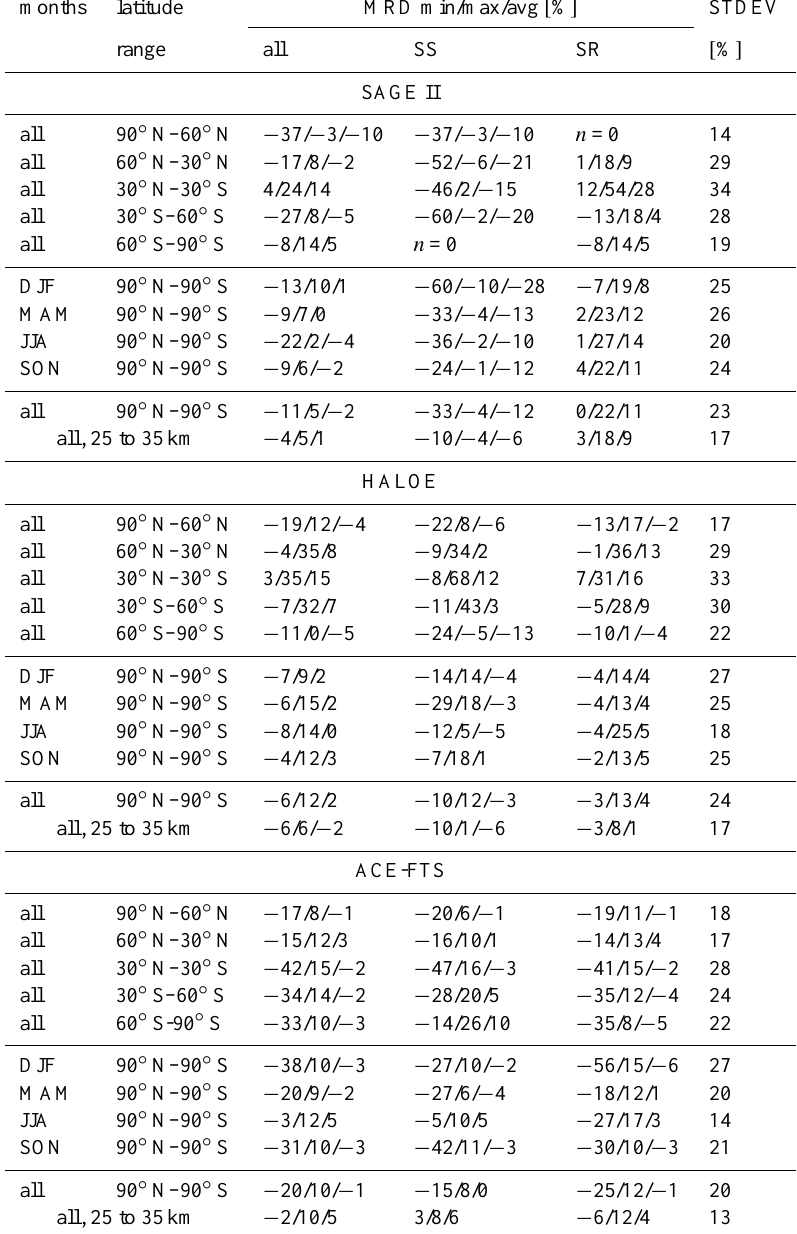
Table 5. Mean relative differences (MRD) for all comparisons at 20 to 40km. Standard deviations (STDEV) are calculated for each subset of collocations in the given altitude